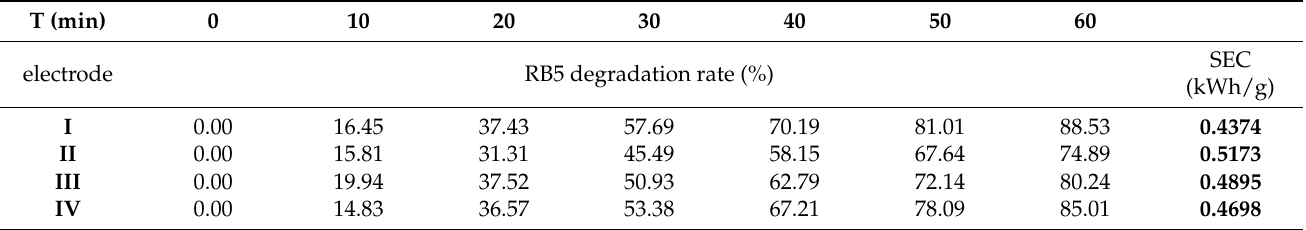
Table 3. Specific energy consumption (SEC) during RB5 treatment, a comparison of different electrode combinations.